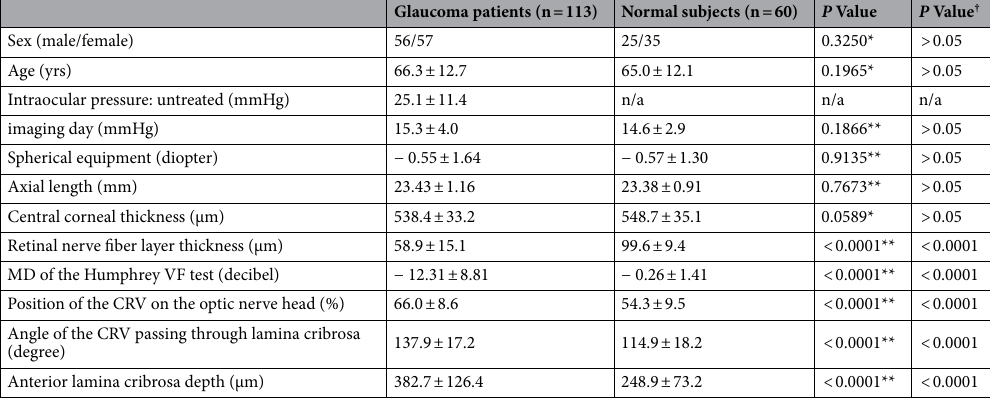
Table 1. Demographic data of the subjects. Values are shown in means ± standard deviations. P values < 0.05 are noted in boldface. For position of the CRV on the optic nerve head, greater percentage indicates more nasal displacement. For angle of the CRV passing through lamina cribrosa, greater degree indicates more nasally angled path. * Student t test. **Mann–Whitney U test. † P value after Bonferroni correction. n/a, not applicable; MD, mean deviation; VF, visual field; CRV, central retinal